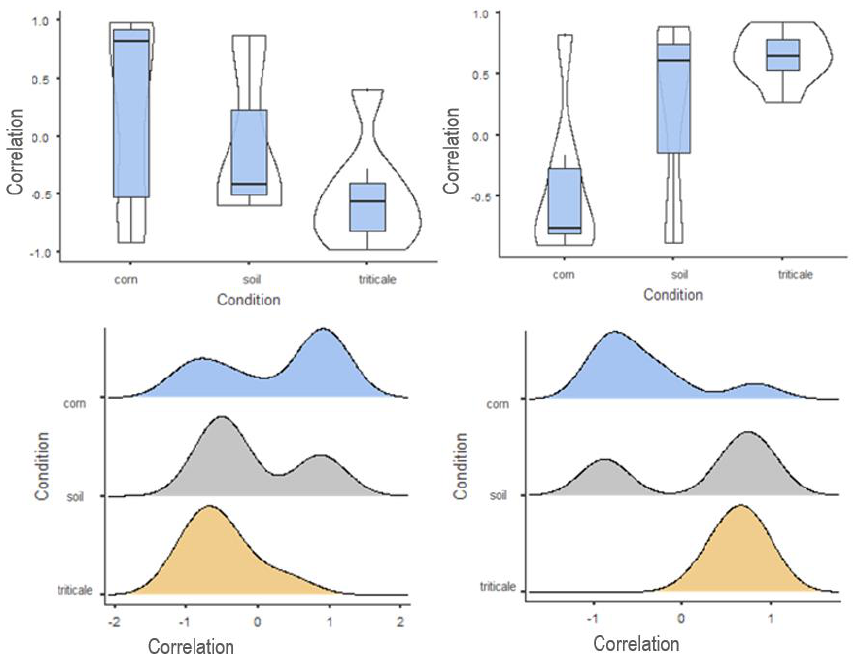
Figure 8. In the left column is the distribution of correlation values between the maps produced with the geoelectric method and with the MCARI2 spectral index. In the left column is the distribution of correlation values between the maps produced with the geoelectric method and with the NDWI spectral